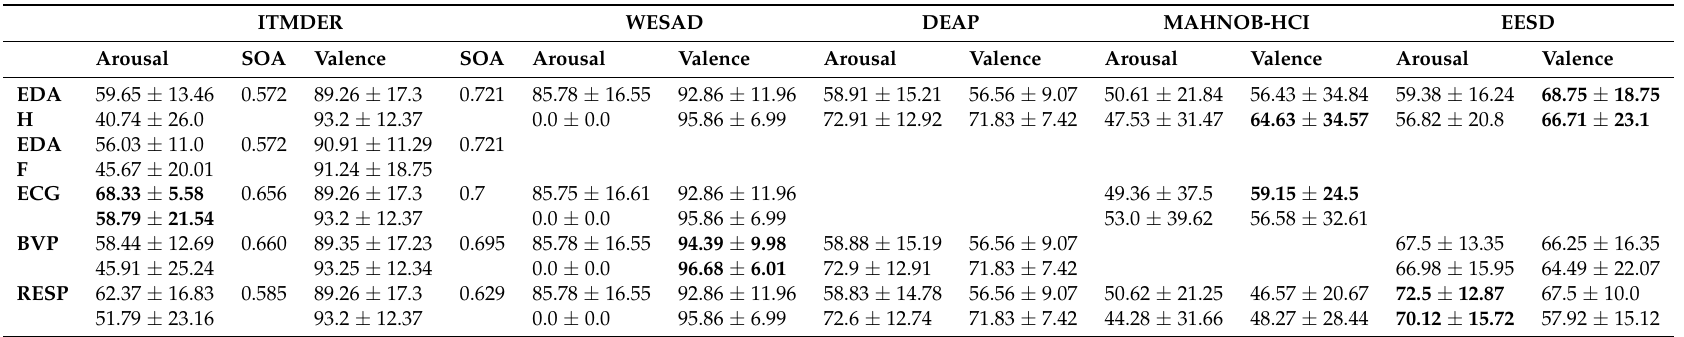
Table 2. Experimental results in terms of the classifier’s Accuracy (1st row) and F1-score (2nd row) in %. All listed values are obtained using Leave-One-Subject-Out (LOSO). Nomenclature: SOA—State-of-the-art results; EDA H, EDA F—EDA obtained on a device placed on the hand and finger, respectively. The SOA column contains the results found in the literature [7]. The best results are shown in bold.